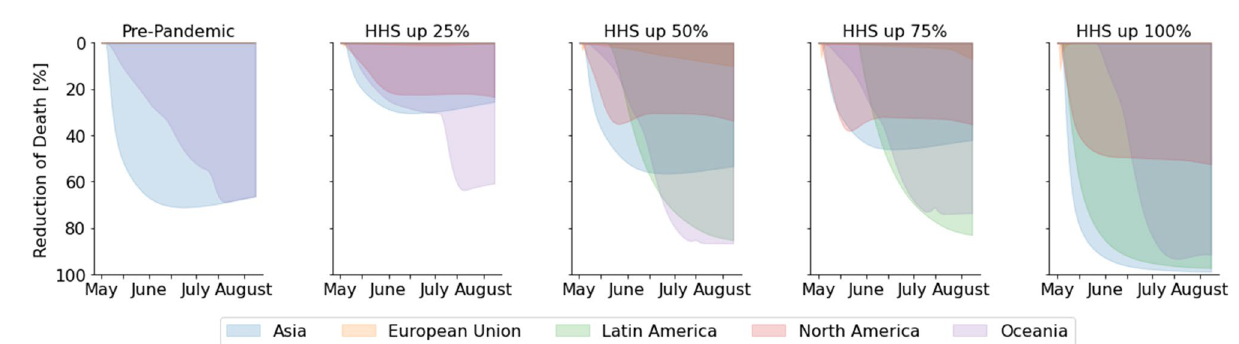
Figure 4. Disease impacts for increased HHS capacity. Assuming coordination of the supply chain is possible, the diagrams show the percentage of fatality reduction in different regions with the increasing production capacity of HHS resources, in terms of the pre-pandemic capacity (100), ramp-up by 25% (125), ramp-up by 50% (150), ramp-up by 75% (175) and , ramp-up by 100% (200). The fatalities simulated in the pre-pandemic capacities is used as a benchmark to calculate the reduction